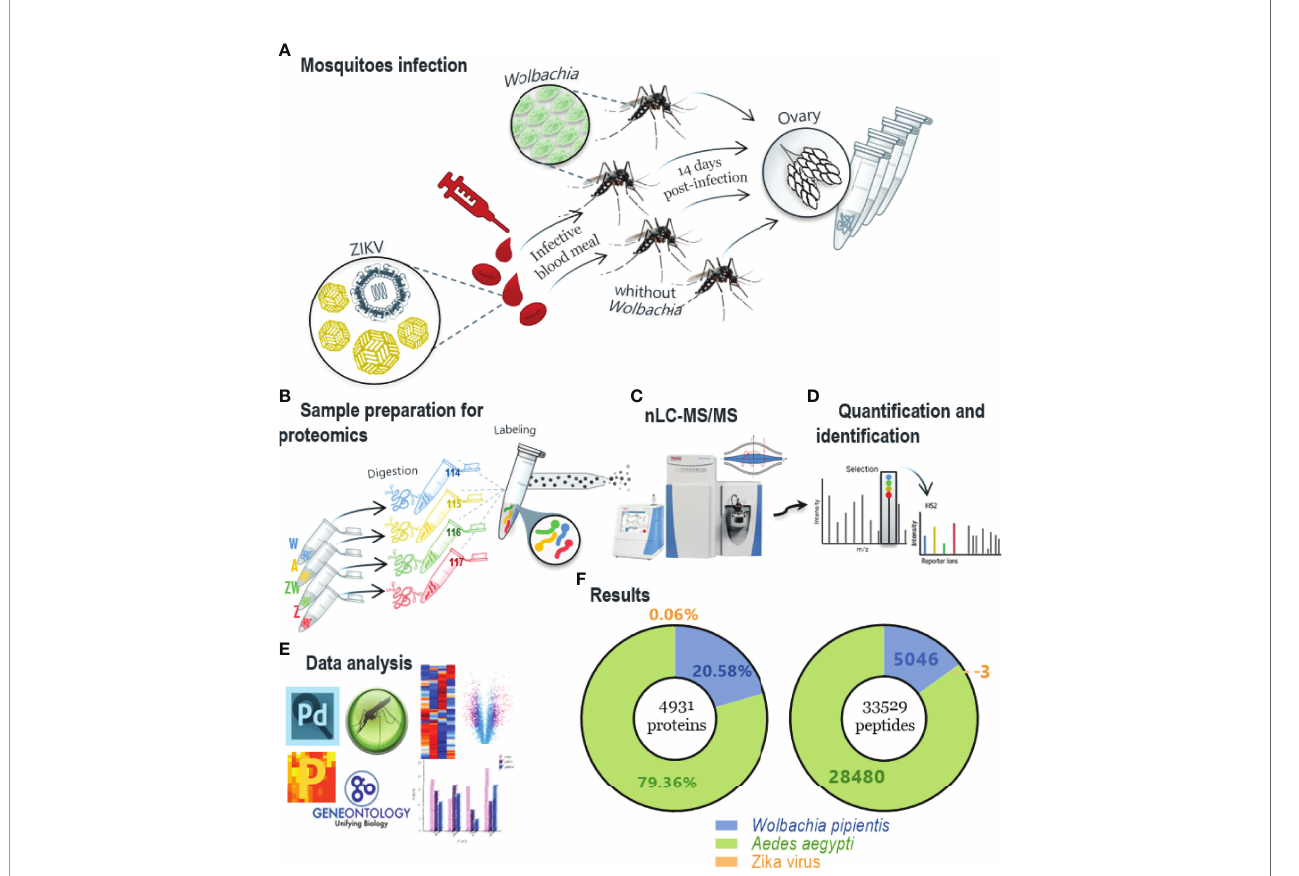
FIGURE 1 | Work fl ow method and main protein identi fi cation results. (A) Mosquitoes infection protocol in which mosquitoes infected and non-infected with Wolbachia were captured and half were infected with ZIKV in vitro; ovaries were extracted after 14 days. (B) Sample preparation for proteomics, using trypsin enzyme for digestion step and peptides labeling was performed with iTRAQ-4plex and mixed in a 1:1:1:1 ratio; labeled peptides were fractionated of fl ine using HILIC chromatography; samples were named depending on its infection condition: A - non-infected mosquitoes; W - Wolbachia infected; Z - ZIKV infected. (C, D) The pool of fractions was analyzed by nLC – MS/MS in Q-Exactive Plus mass spectrometer and the fragmentation scheme shows reporter ions at the low m/z region used for relative quanti fi cation of the peptides/proteins. (E) Data analysis was fi rst performed with Proteome Discoverer 2.4 software using Ae. aegypti, Wolbachia and ZIKV peptides database and after statistical and bioinformatics analysis was done in software Perseus using VectorBase to enrich proteins differentially regulated for GO and KEGG. (F) Summary proteins identi fi cation result, where a total of 4931 proteins and 33,529 peptides were identi fi ed, including the three